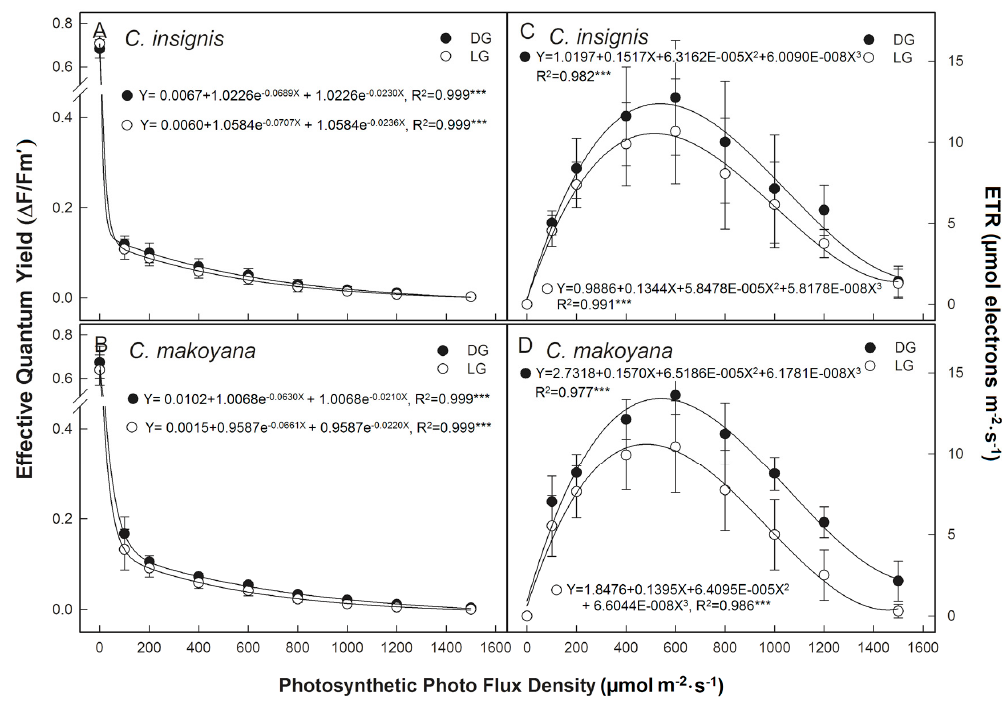
Figure 3. Light response changes in effective quantum yield ( ∆ F/Fm’, ( A , B )) and electron transport rate (ETR, ( C , D )) from dark green leaf sector (black circle, DG) and light green leaf sector (white circle, LG) in Calathea makoyana and C. insignis. Vertical bars indicate the standard deviation ( n = 5). *** p <